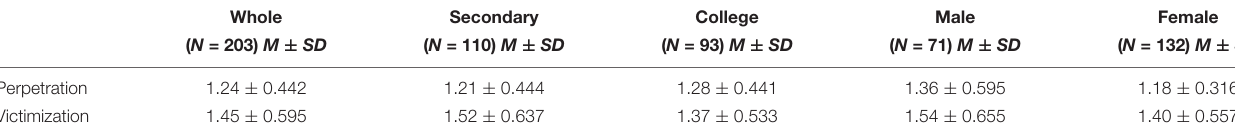
TABLE 1 | Means and standard deviations for reports of cyberbullying involvement by school level and gender.